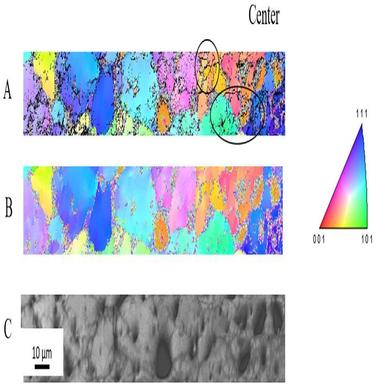
The EBSD of the near center region of the pellet. The internal restructuring of the fuel can be observed. The dark spots and corresponding areas of random index patterns are pores in the material. A) Is the IPF with low angle grain boundaries (2–15 °) marked in the image. The black circles highlight the regions of subdivision. B) The IPF and without the low angle grain boundaries marked. C) The image quality.